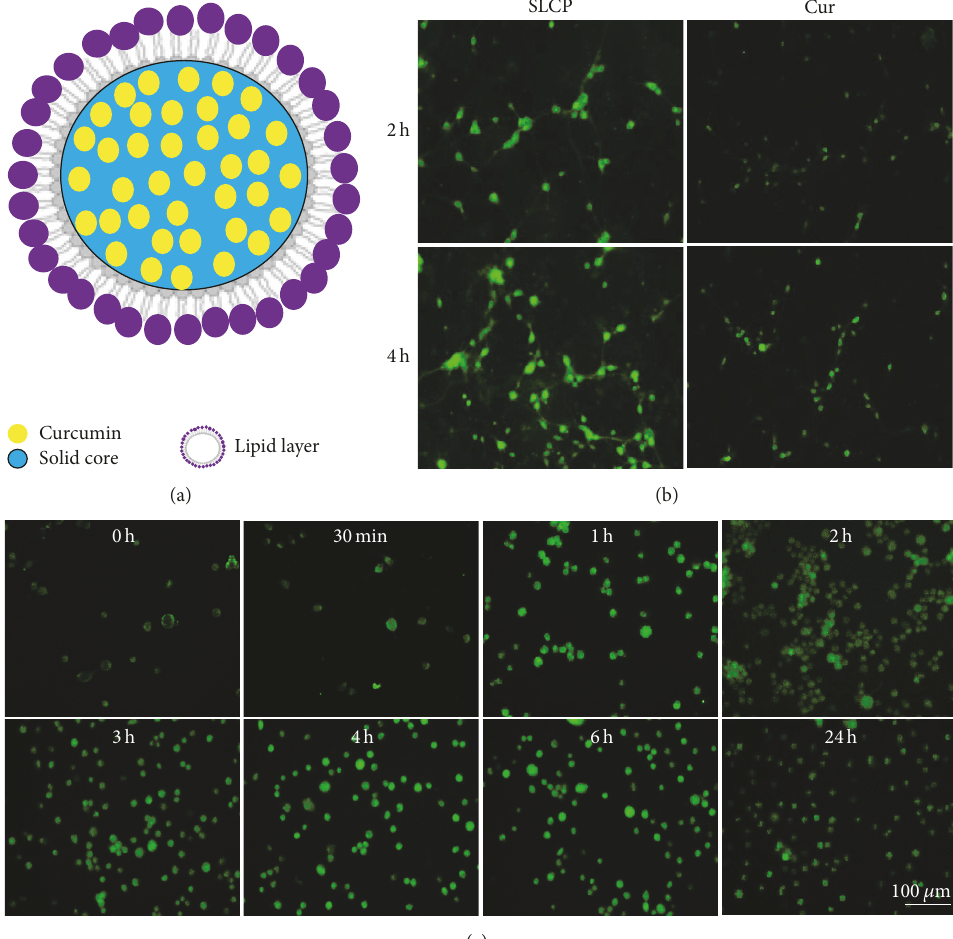
Figure 1: SLCP has greater cellular permeability than dietary Cur. (a) Schematic diagram showing the formulation of SLCP, indicating that Cur is coated with solid lipid core of a lipid bilayer. (b) Mouse embryonic primary hippocampal neurons (7 days old) were treated with Cur and SLCP in different time points, with SLCP showing greater permeability than dietary Cur after 2 and 4 h incubation. N2a cells were treated with SLCP (1 𝜇 M) up to 24 h and maximum permeability was observed after 1h with no significant change of permeability, even up to 24h of incubation. Scale bar indicates 100 𝜇 m and is applicable to all